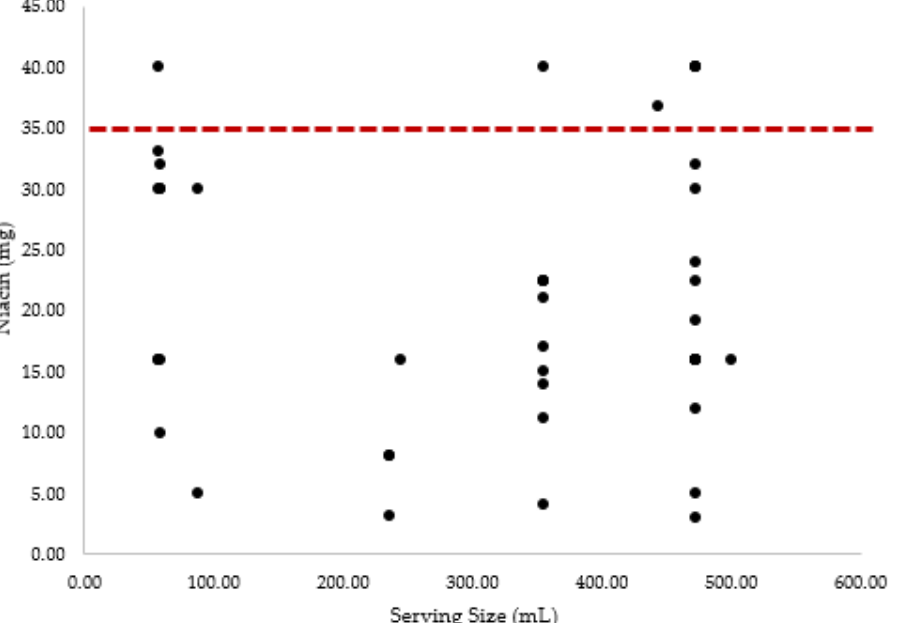
Figure 1. Niacin (vitamin B3) amounts plotted against serving size. Dashed line denotes UL for niacin (35 mg).